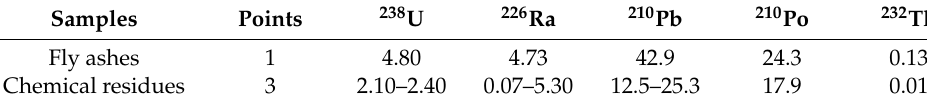
Table 3. Radioactivity concentrations in fly ashes and chemical residues (Bq/g).